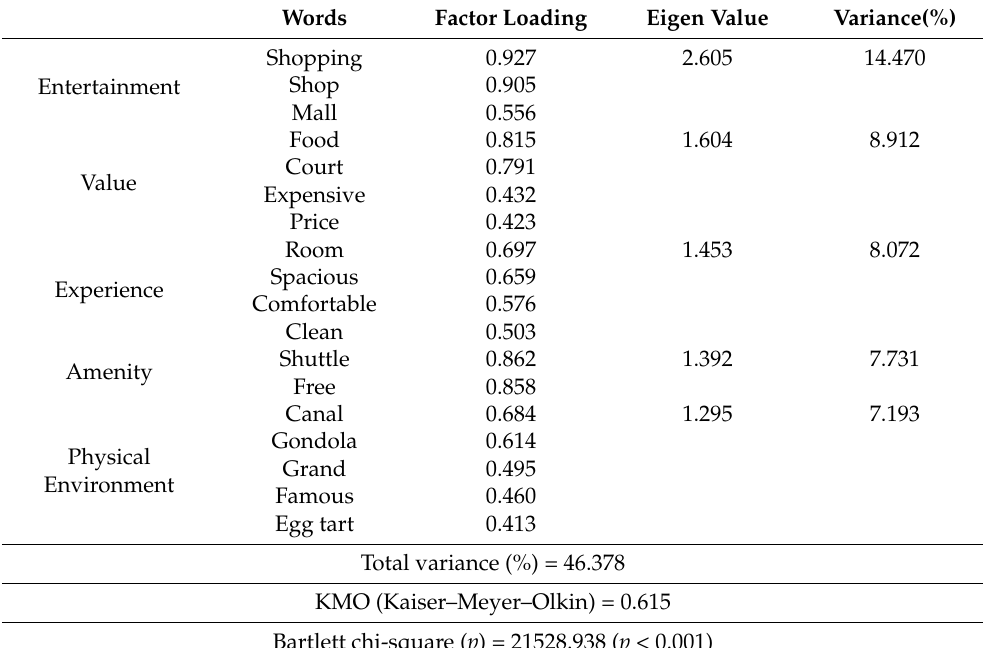
Table 7. Result of the factor analysis (The Venetian Hotel in